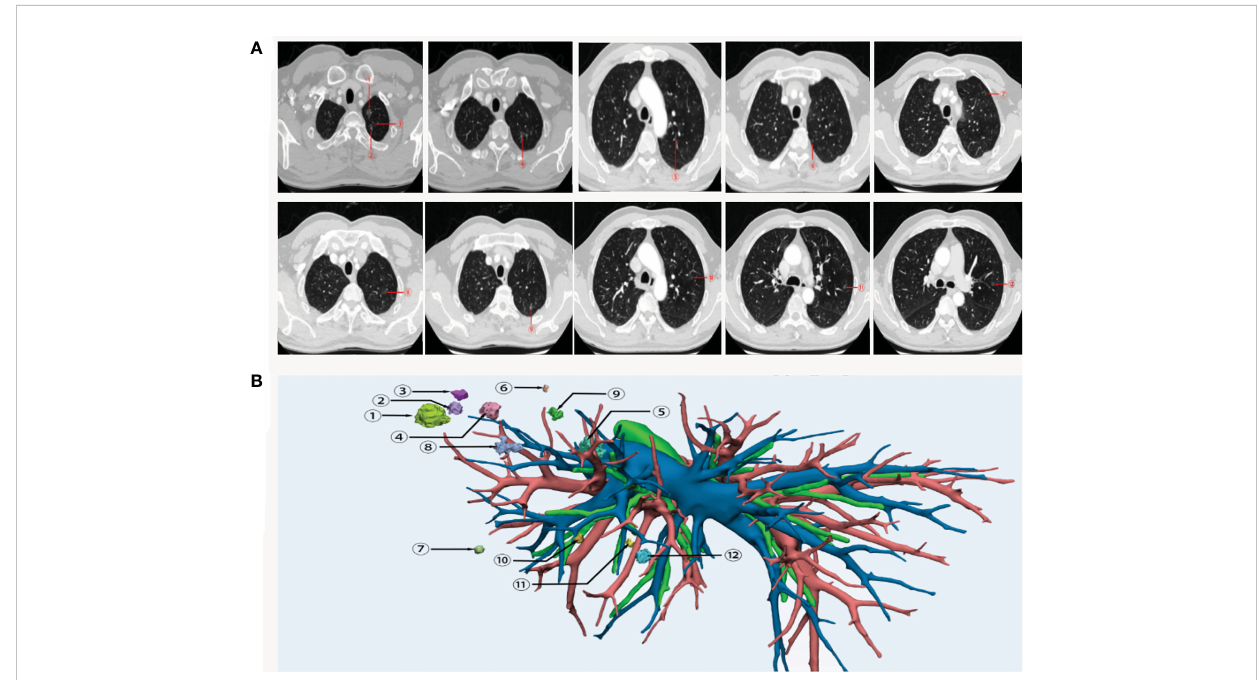
FIGURE 1 CT images (A) and 3D reconstruction (B) of this patient with early-stage MPLC. Nodule 1, nodule 3, nodule 5, nodule 6 and nodule 9 were identi fi ed as MIA. Nodule 4, nodule 12, and nodule 11 were identi fi ed as AIS. No cancer cells were found in nodule 2, nodule 7, nodule 8, and nodule 10. MPLC, multiple primary lung cancer; AIS, adenocarcinoma in situ; MIA, minimally invasive